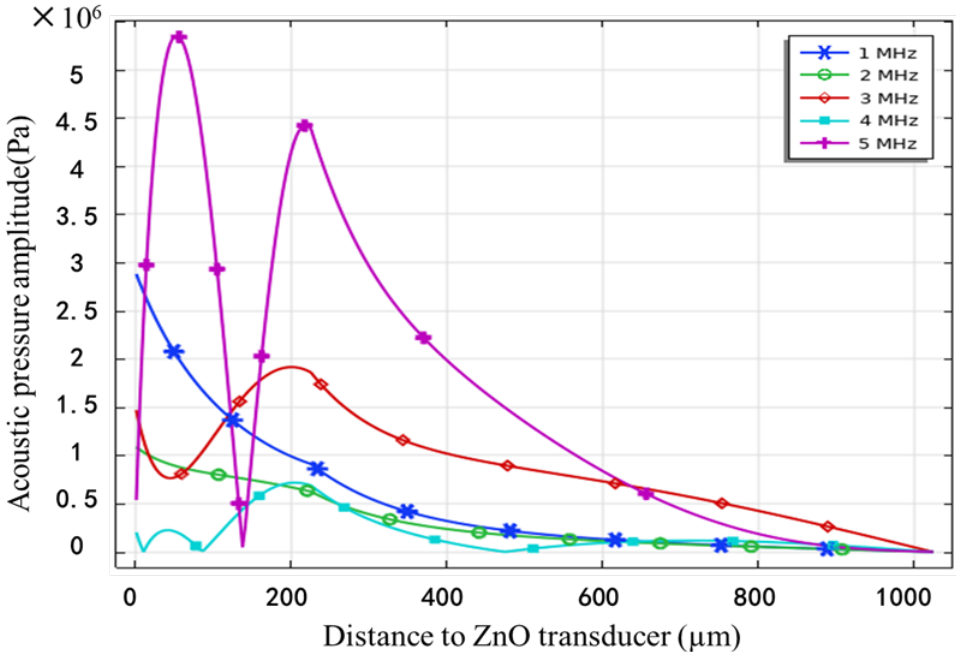
Figure 5. Acoustic pressure distribution along in the normal axis, generated by the device with the cover.